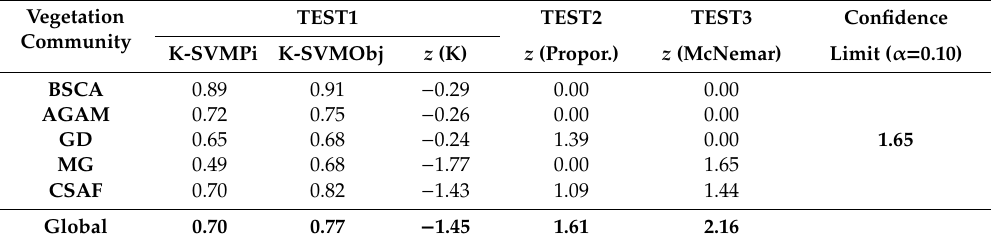
Table 7. Test results of the comparison of the SVMPi and SVMObj classifications. For abbreviations, see main